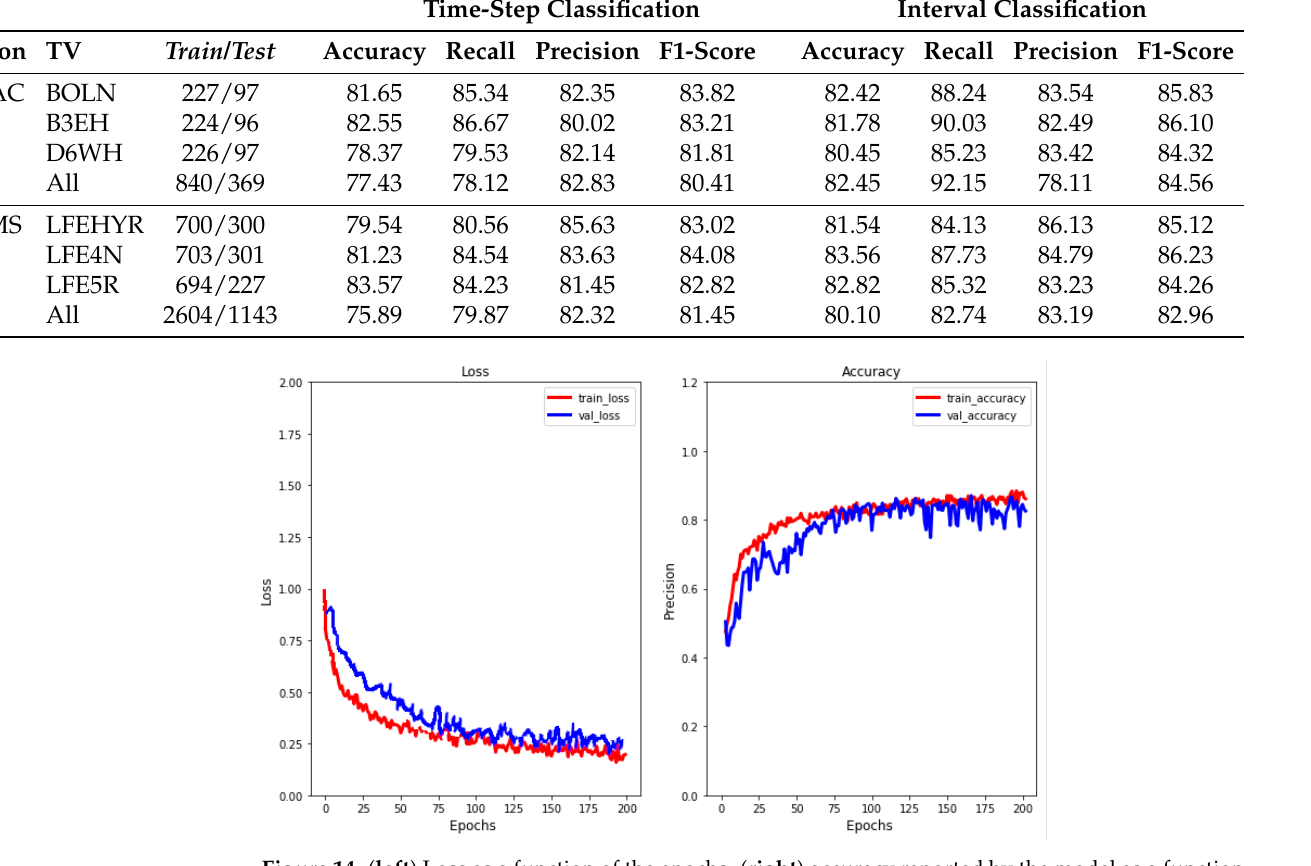
Table 2. Performance of the CNN-based model for different TVs in the MUAC and REIMS regions at the time-step level, and at the interval level. Train/Test column shows the number of 30-min intervals used.